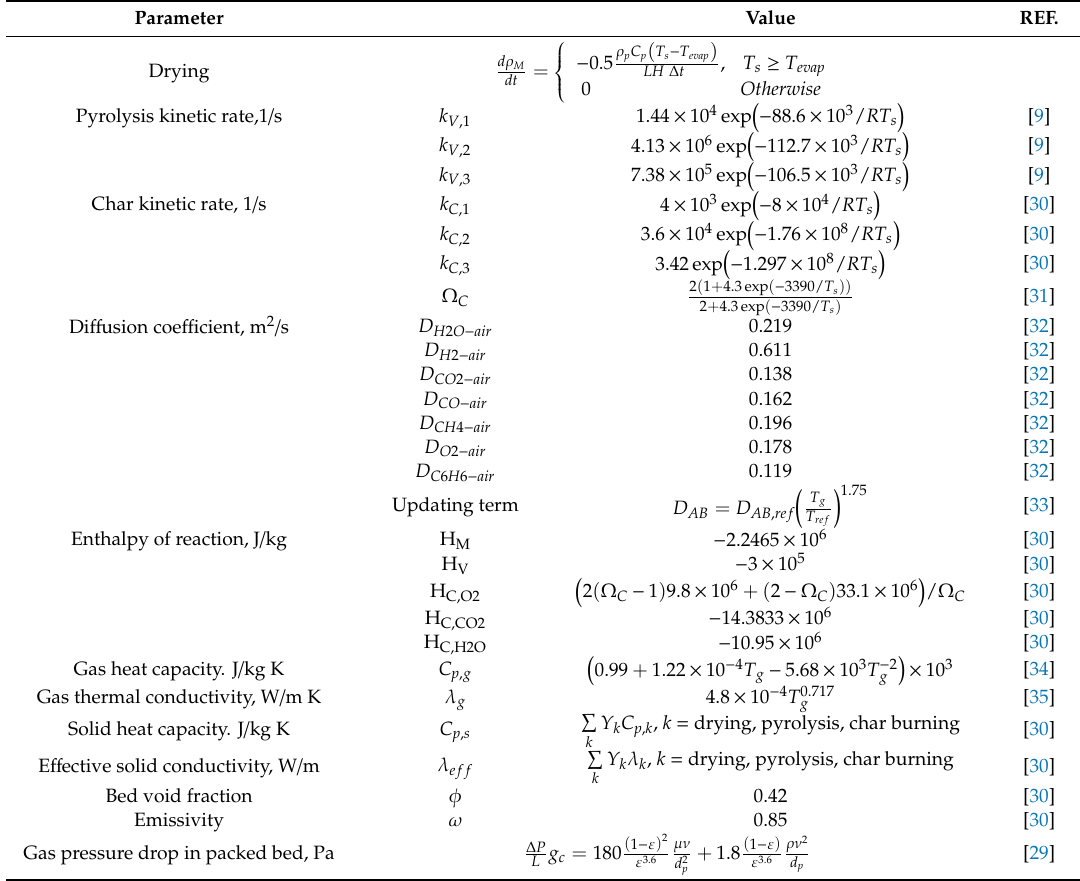
Table 2. Modeling coe ffi cients and fuel